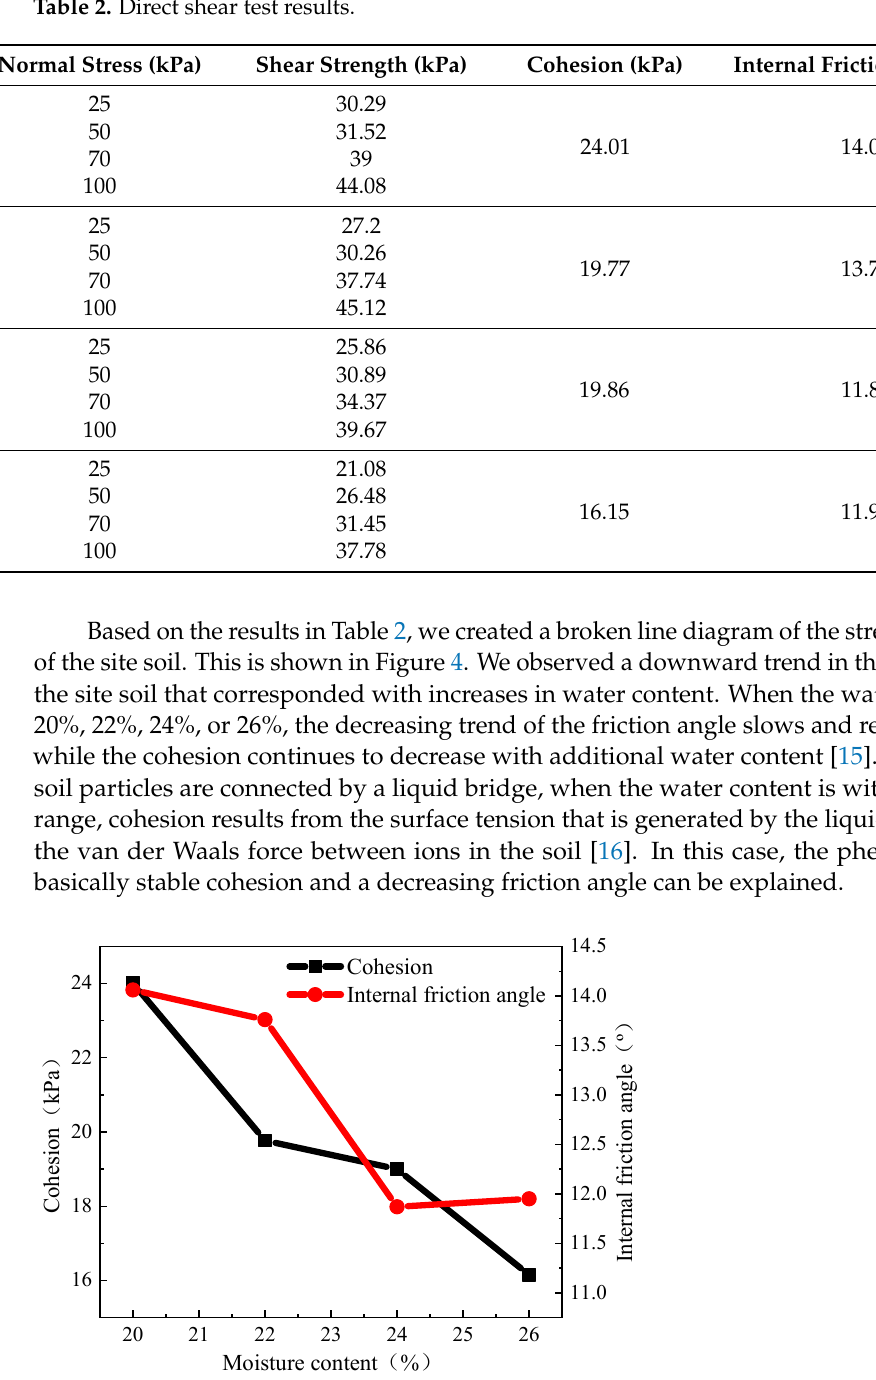
Figure 4. Mechanical properties of the site soil.